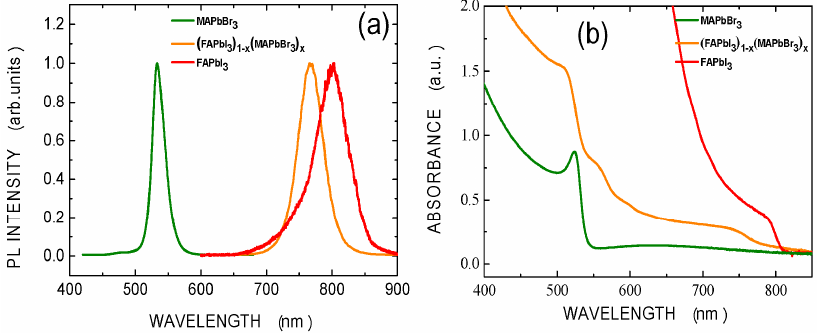
Figure 2. ( a ) PL and ( b ) absorption spectra of MAPbBr 3 , (FAPbI 3 ) 1 − x (MAPbBr 3 ) x , and FAPbI 3 films deposited on glass substrates.